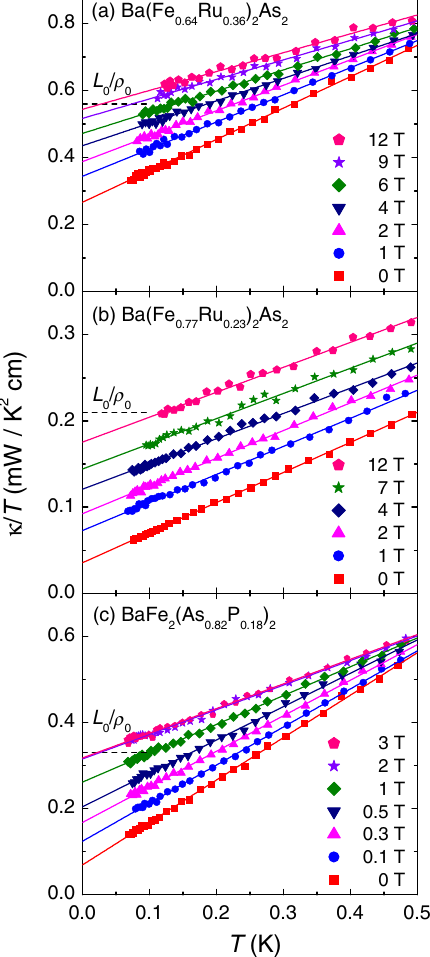
FIG. 3. Low-temperature in-plane thermal conductivity of (a) Ba ð Fe 0 : 64 Ru 0 : 36 Þ 2 As 2 (called sample OP20K in the paper), (b) Ba ð Fe 0 : 77 Ru 0 : 23 Þ 2 As 2 (sample UD17K), and (c) BaFe 2 ð As 0 : 82 P 0 : 18 Þ 2 (sample UD4K) in zero and finite mag- netic fields applied along the c axis. The solid lines are (cid:1)=T ¼ a þ bT fit to all the curves, respectively. The dashed horizontal lines are the normal-state Wiedemann-Franz law expectation =(cid:3) L 2 : 45 (cid:3) 10 (cid:1) 8 W(cid:2) K (cid:1) 2 , L 0 0 , where 0 is the Lorenz number, and normal-state (cid:3) 0 ¼ 44 , 115, and 74 (cid:2) (cid:2) cm , respectively.